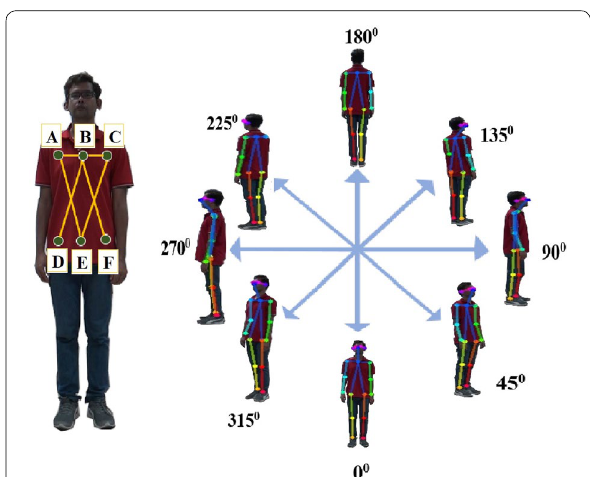
Fig. 4 Examples of body orientation